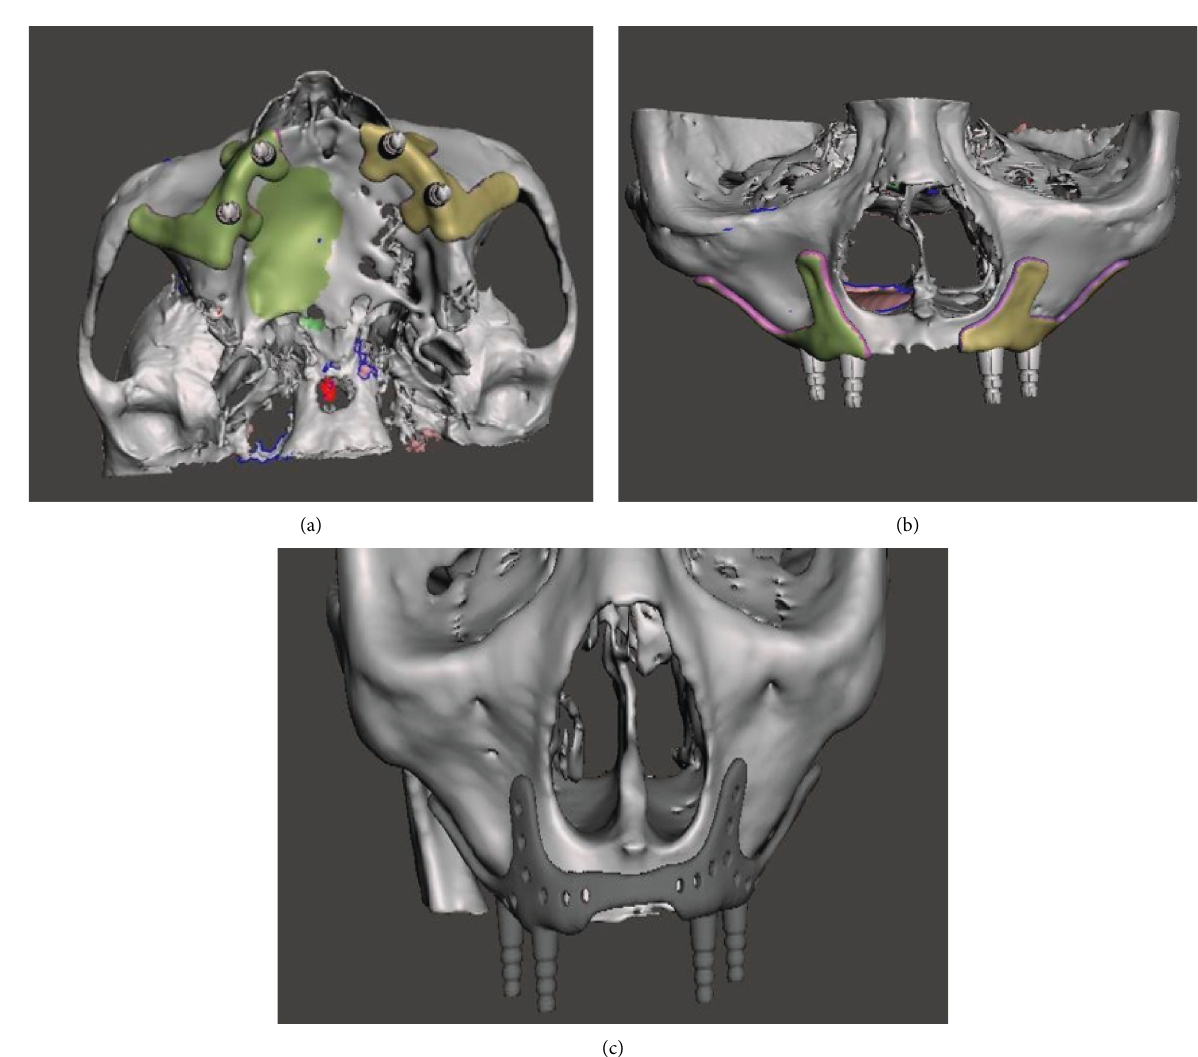
Figure 2: (a) Implant iteration 1 (bottom view), (b) implant iteration 1 (front view), and (c) implant iteration